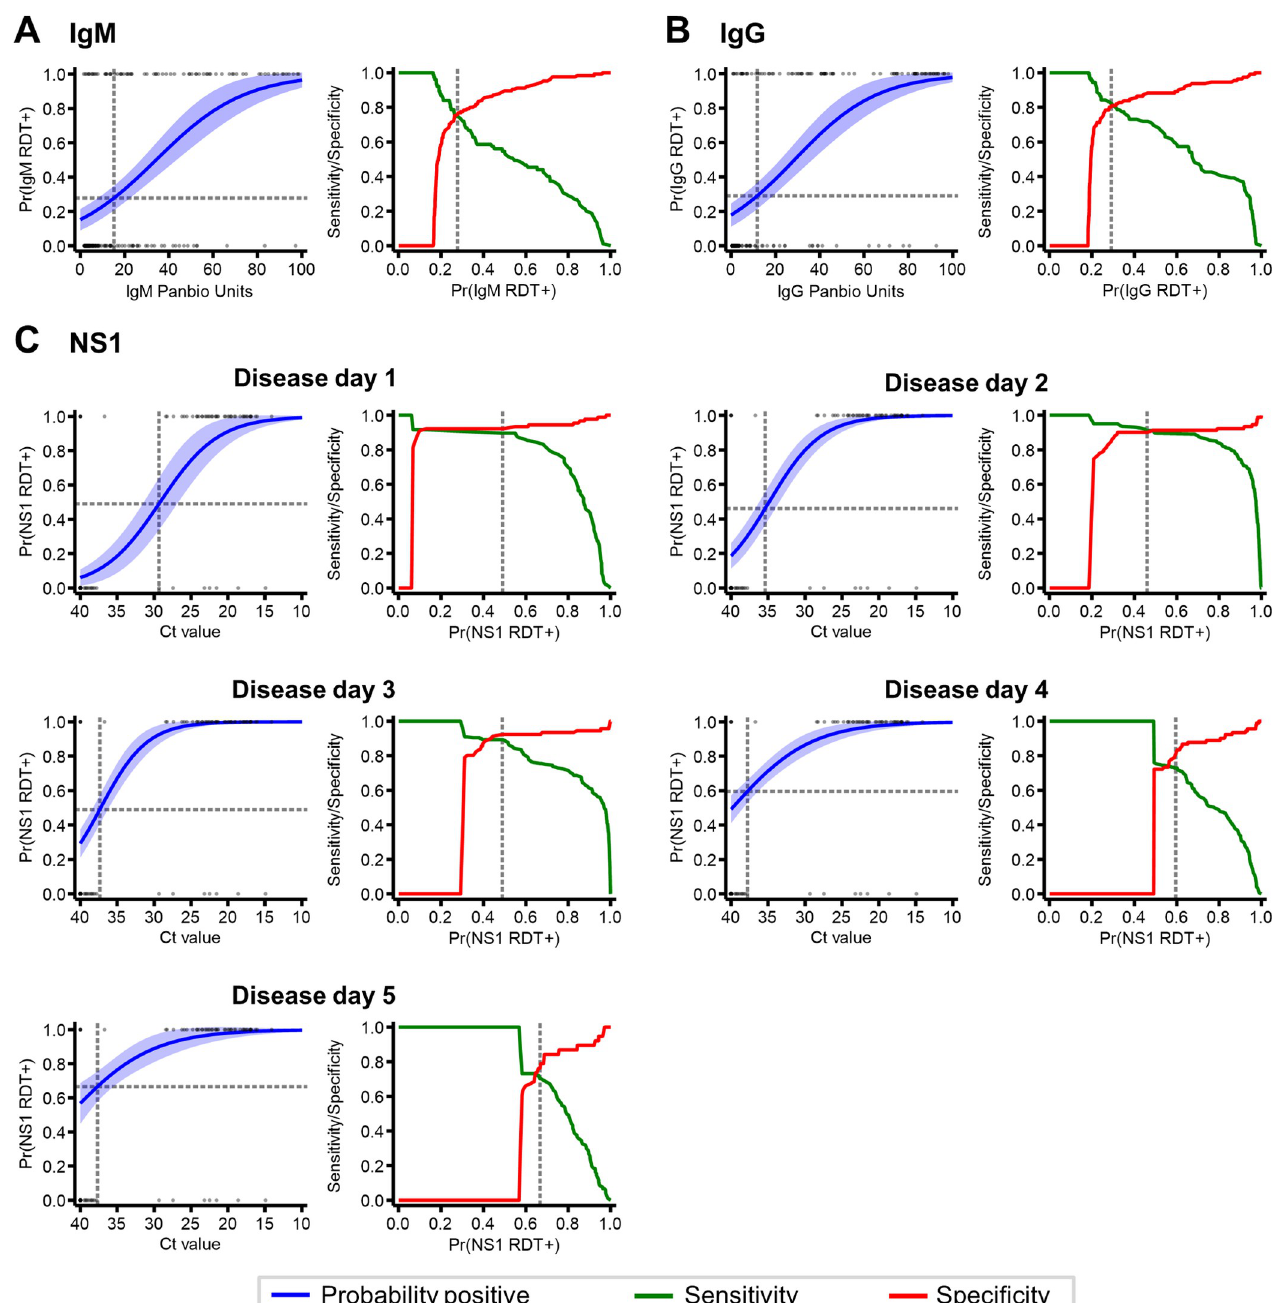
Fig 2. Estimated probability of being DENV RDT positive according to corresponding laboratory-derived metrics using logistic regression modelling. A: IgM RDT positivity according to IgM panbio units and the corresponding sensitivity/specificity among patients from Indonesia (N:200) B: IgG RDT positivity according to IgG panbio units and the corresponding sensitivity/specificity among patients from Indonesia (N:200) C: NS1 RDT positivity according to viremia (Ct value) and the corresponding sensitivity/specificity stratified by disease day among patients from Vietnam (N: 1,217). Grey dash: estimated laboratory-derived metric threshold for RDT positivity according to the optimal Youden’s J index value. thresholds were considered RDT positive for each antibody. This resulted in 43.0% (86/200) with estimated IgM RDT positive outcomes which corresponded to 37.5% (75/200) with actual